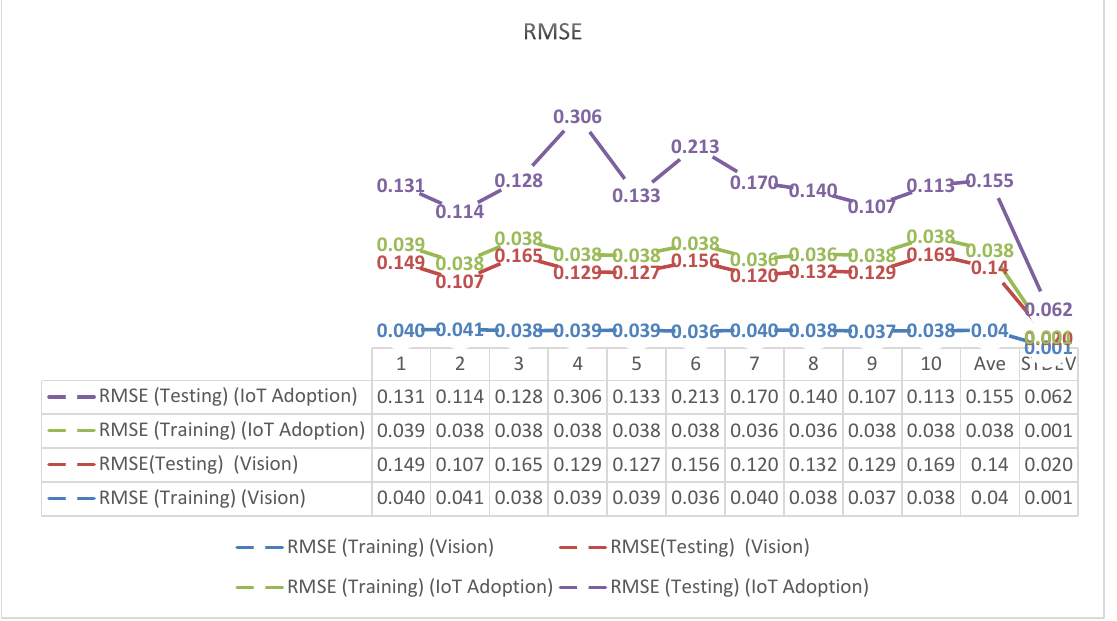
Fig. 4. The root mean square of errors (RMSE)